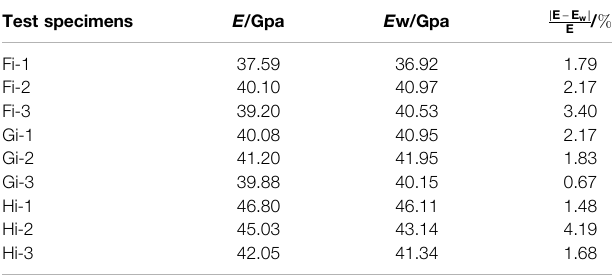
TABLE 7 | The comparison between E and E w .